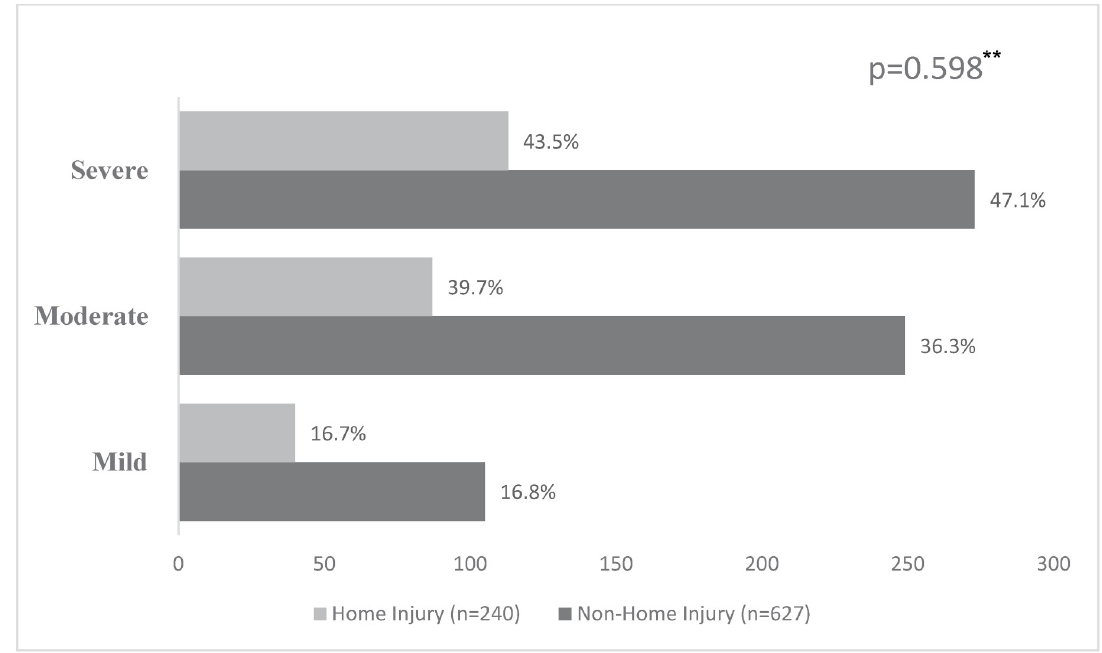
Fig 1. Disabilities � severity reported by home injury vs non-home injury. � Disabilities include any difficulty speaking or communicating; dressing, eating, going to the bathroom; leaving the home, shopping, traveling; engaging with friends/family; going to school; seeing or hearing; standing or walking; picking things up or using their hands; weakness, shortness of breath, fatigue; understanding or remembering things; depression or shame; Individuals could report multiple disabilities �� Pearson’s Chi